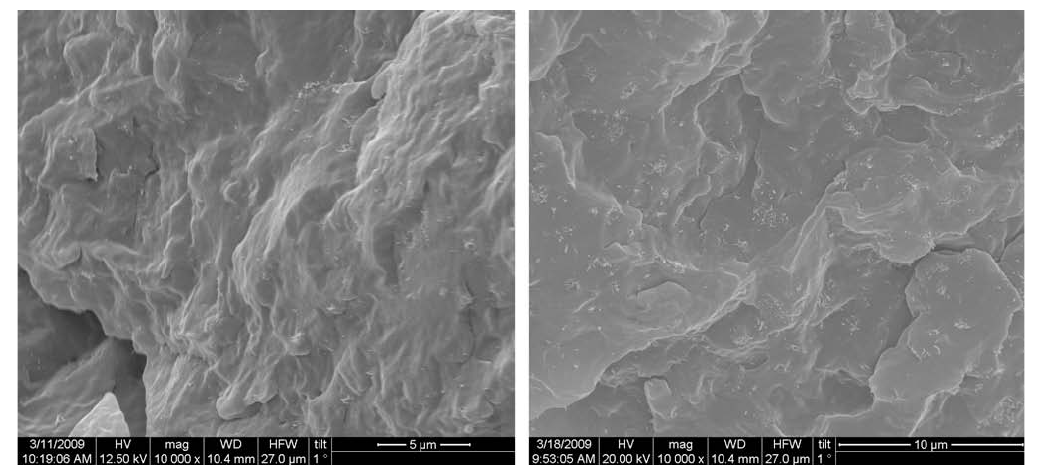
Figure 2. SEM micrographs for the nanocomposites containing 1 wt % (left) and 3 wt % (right) MWCNTs. Reproduced with permission from ref.